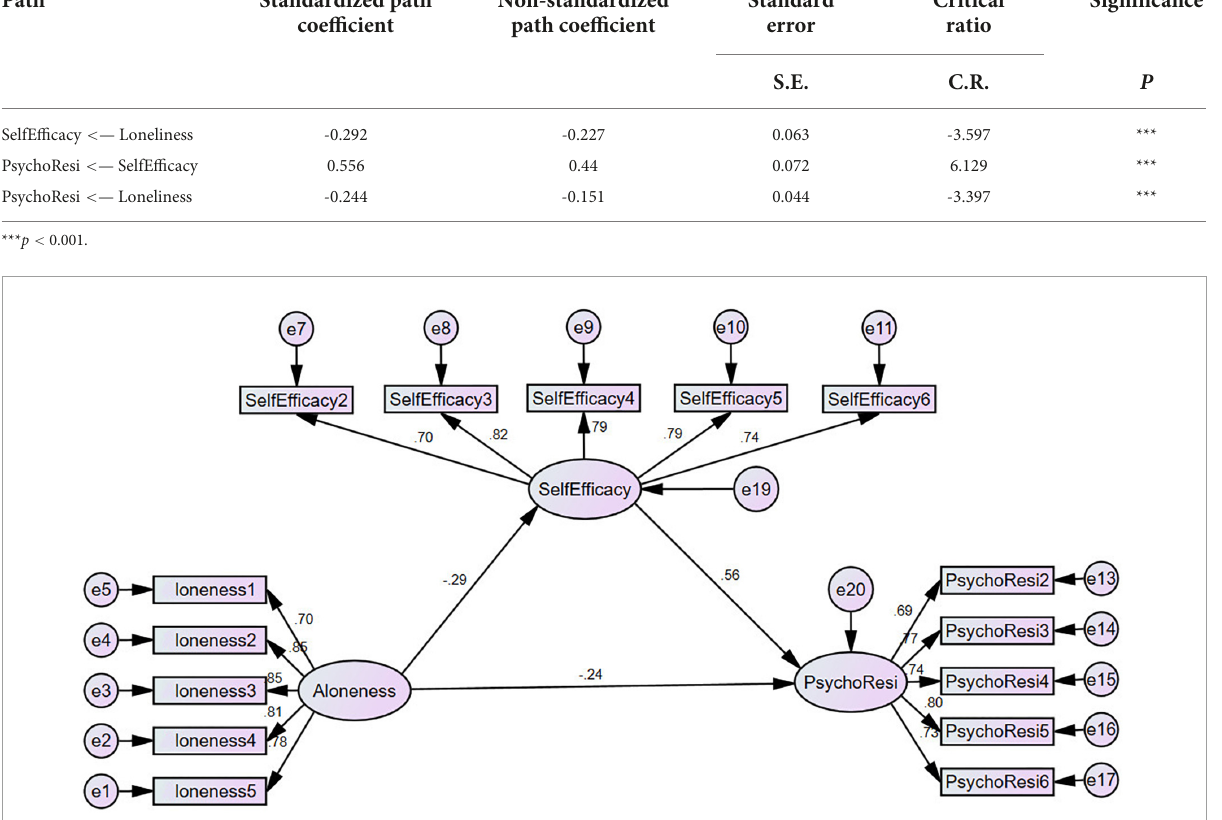
FIGURE1 Structure equation modeling